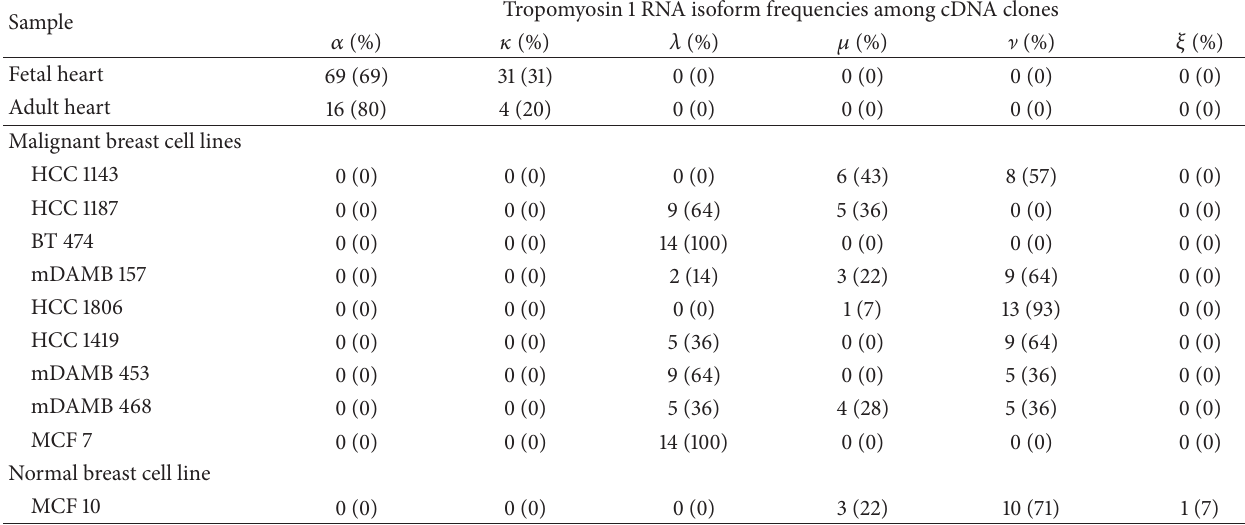
Table 3: Tropomyosin 1 RNA isoform frequencies in various human cardiac tissues and breast epithelial cell lines. Sample